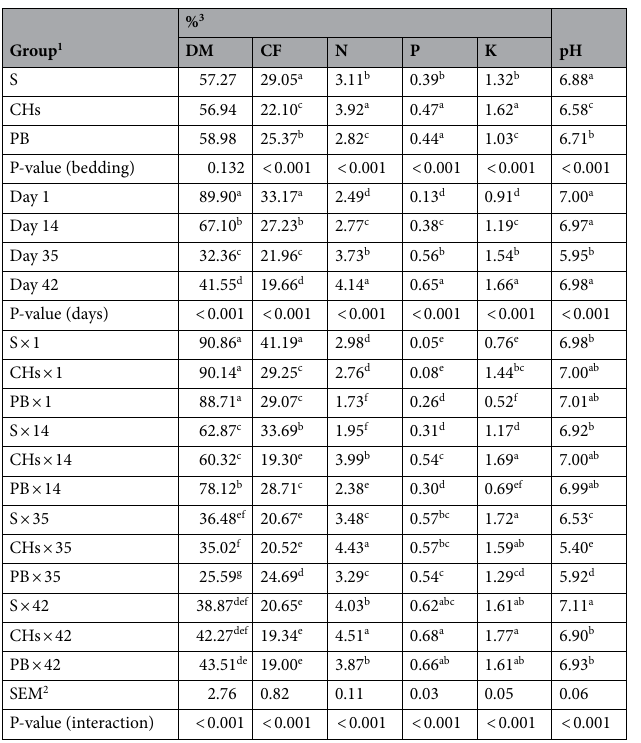
Table 1. Chemical composition and pH value of bedding. a,b Different letters in the column indicate statistically significant differences between the groups, P-value < 0.05; 1 , S, chopped wheat straw bedding; CHs, crude coffee husks bedding; PB, pelleted bedding with 50% of chopped wheat straw and 50% of coffee husks; 2 , SEM, standard error of the mean; 3 , DM, dry matter; CF, crude fiber; N, nitrogen; P, phosphorus; K,